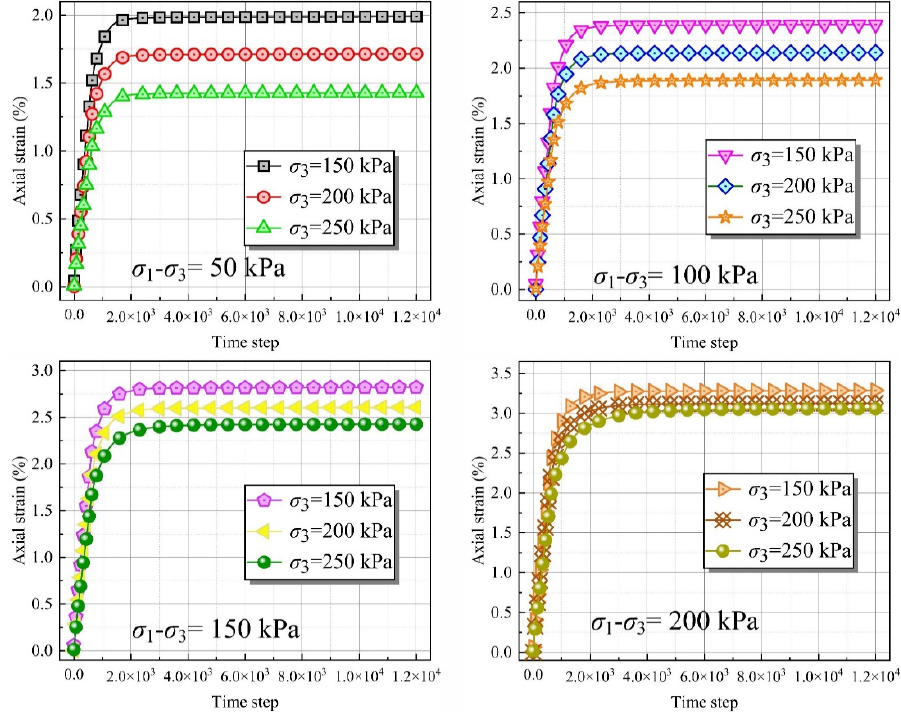
Figure 12. Axial strain-time step curves under different confining pressures at different deviatoric stress levels.